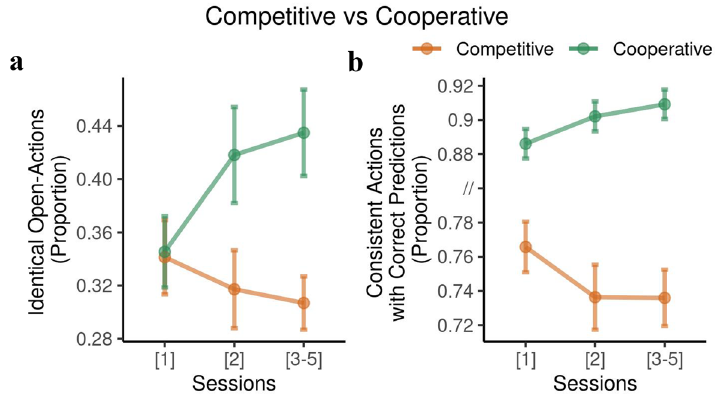
Figure 14. Learning effect in the interactive Tiger Task. Using 2-way mixed effects ANOVA, in ( a ) we observed a main effect of context and a significant interaction indicating that participants in the cooperative context learn to simultaneously open the door through subsequent sessions, compared to the competitive context. For the correctly predicted consistent actions in ( b ) we see a similar effect of context and session. Bars show standard